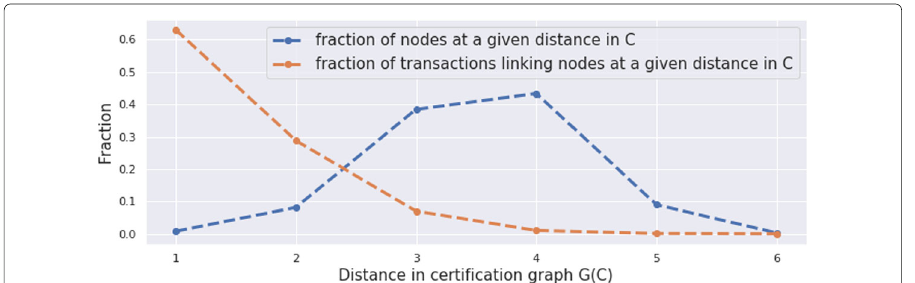
Fig. 8 Fraction of nodes at a given distance in G ( C ) (blue curve), and fraction of transactions between members occuring between nodes at a given distance in G ( C ) (red curve). Although most nodes are at distance 3 and 4 in G ( C ) , a large majority of transactions occurs between directly connected nodes and the fraction decreases as the distance in G ( C ) increases